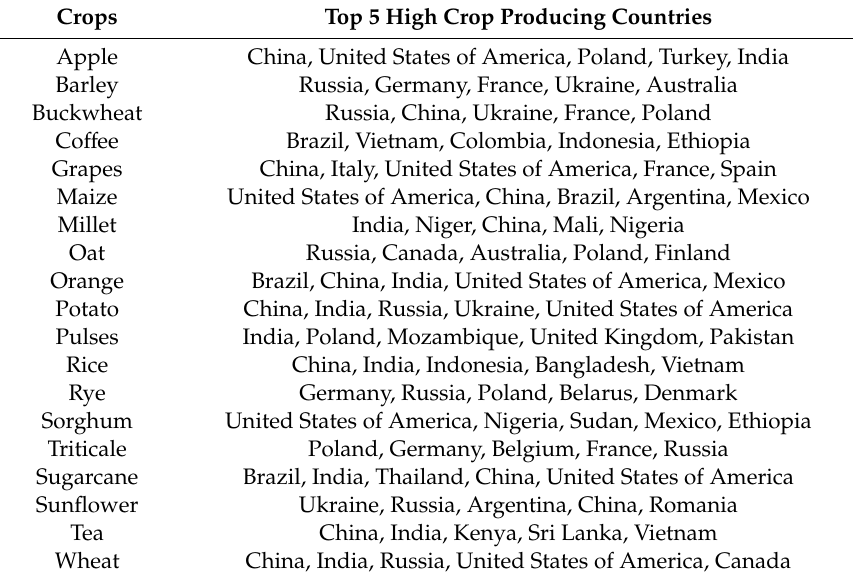
Table 1. Top five crop-producing countries of the world